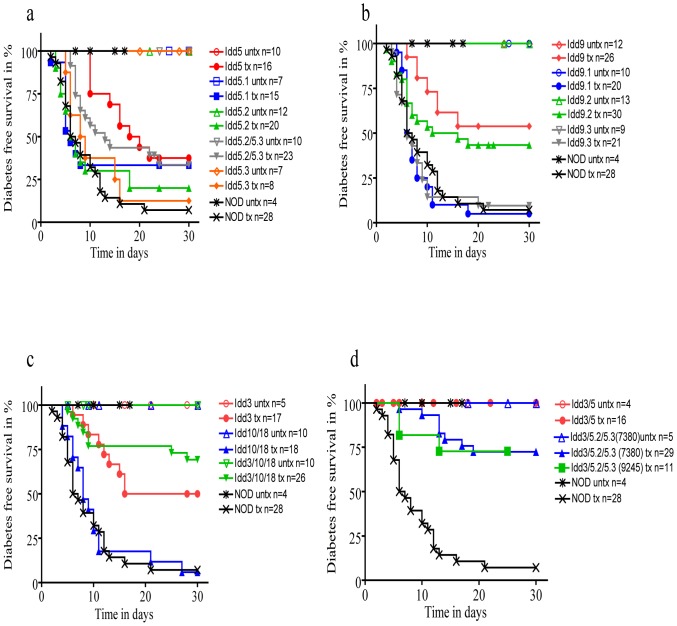
Incidence of diabetes in NOD congenic mouse strains undergoing anti PDL1 treatment.Treatment was started at 10 weeks of age. a): Incidence of diabetes in Idd5 and sub-congenics Idd5.1, Idd5.2, Idd5.3 and Idd5.2/5.3 until day 30 after anti PDL1 treatment. In Idd5 mice (n = 16) 62.5% developed diabetes, in Idd5.1 (n = 15) 66.6%, in Idd5.2 (n = 20) 80%, in Idd5.3 (n = 8) 87.5% and in Idd5.2/5.3 (n = 23) 66.5%. NOD mice (n = 28) had a 92.5% incidence of diabetes by day 30. All control treated mice did not develop diabetes. b): In Idd9 (n = 26) 46.15% developed diabetes, in Idd9.1 (n = 20) 95%, in Idd9.2 (n = 30) 56.6% and in Idd9.3 (n = 21) 90.5%. c): Idd3 (n = 17) developed diabetes at a rate of 50%, Idd10/18 (n = 18) at 94.1%, Idd3/10/18 (n = 26) at 30.8%. d): In Idd3/5 (n = 16) 0% of anti - PDL1 treated mice developed diabetes, in Idd3/5.2/5.3 (n = 13) 15.4%. Statistics and cumulative incidence for the strains are shown in separate Tables for Figure 1. P-values were calculated using Log-rank (Mantel-Cox test).